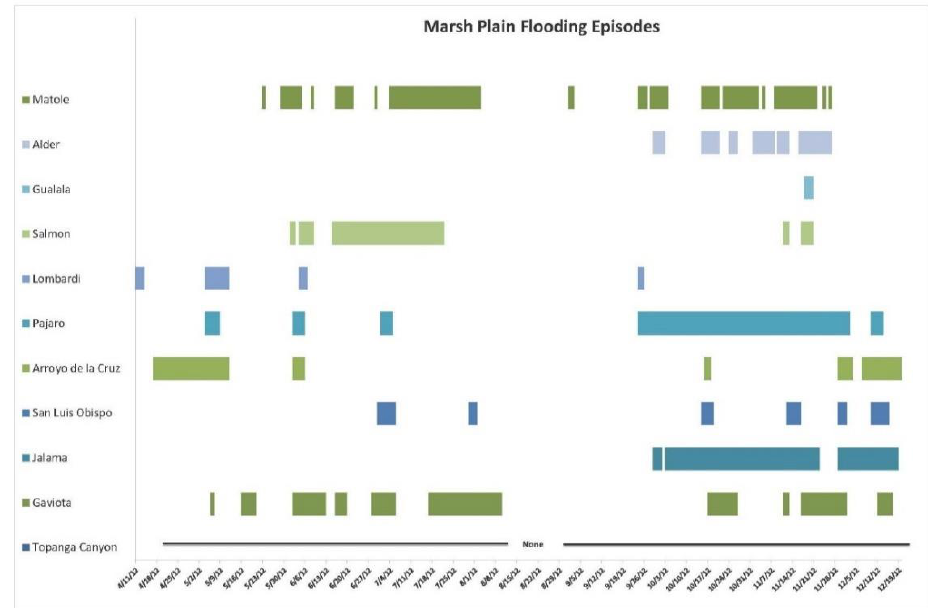
Figure 5. Patterns of marsh plain inundation associated with mouth state of intermittent estuaries in California. Y-axis lists individual estuaries monitored and shaded bars indicate period of time when the marsh plain was flooded due to mouth closure. From [17], reprinted with permission.